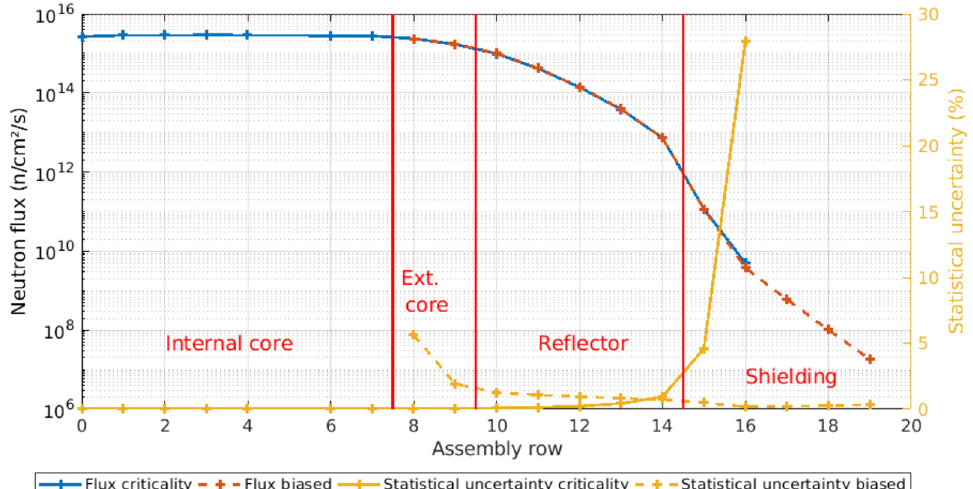
Fig. 12. Flux in the core and in the radial shielding of ASTRID calculated with and without variance reduction